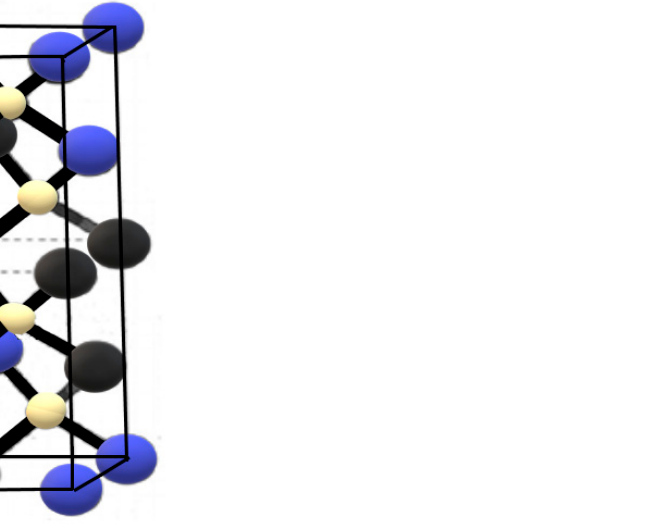
Figure 1. The crystal structure of ZnGeP2 is of the chalcopyrite type. Zn, Ge, P are the atoms of the crystal lattice.